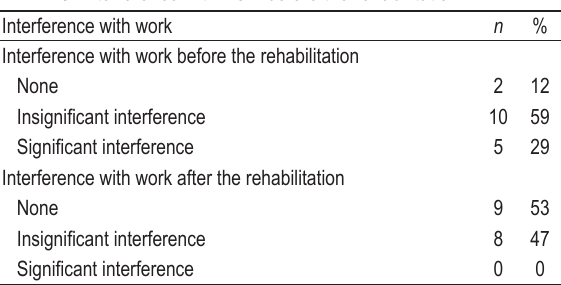
TABLE 8. Interference with work before the rehabilitation